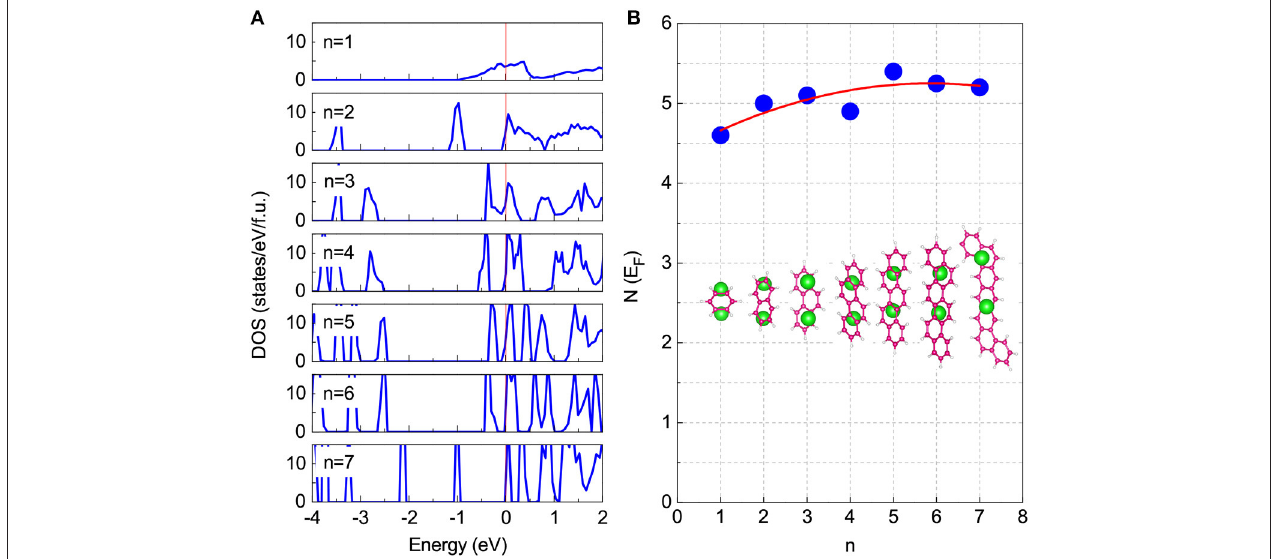
FIGURE 5 | Total density of states (DOS) for K 2 -doped cases. n represents the number of benzene rings in system. These systems include K 2 C 6 H 6 ( n = 1), charged (K 2 C 10 H 8 ) + 0.1 e ( n = 2), K 2 C 14 H 10 ( n = 3), charged (K 2 C 18 H 12 ) + 0.1 e ( n = 4), charged (K 2 C 22 H 14 ) + 0.1 e ( n = 5), charged (K 2 C 26 H 16 ) + 0.1 e ( n = 6), and charged (K 2 C 30 H 18 ) + 0.1 e ( n = 7), respectively. (A) The results of DOS for K 2 -doped cases are presented. Zero energy denotes the Fermi level. (B) The DOS at Fermi level (N(E